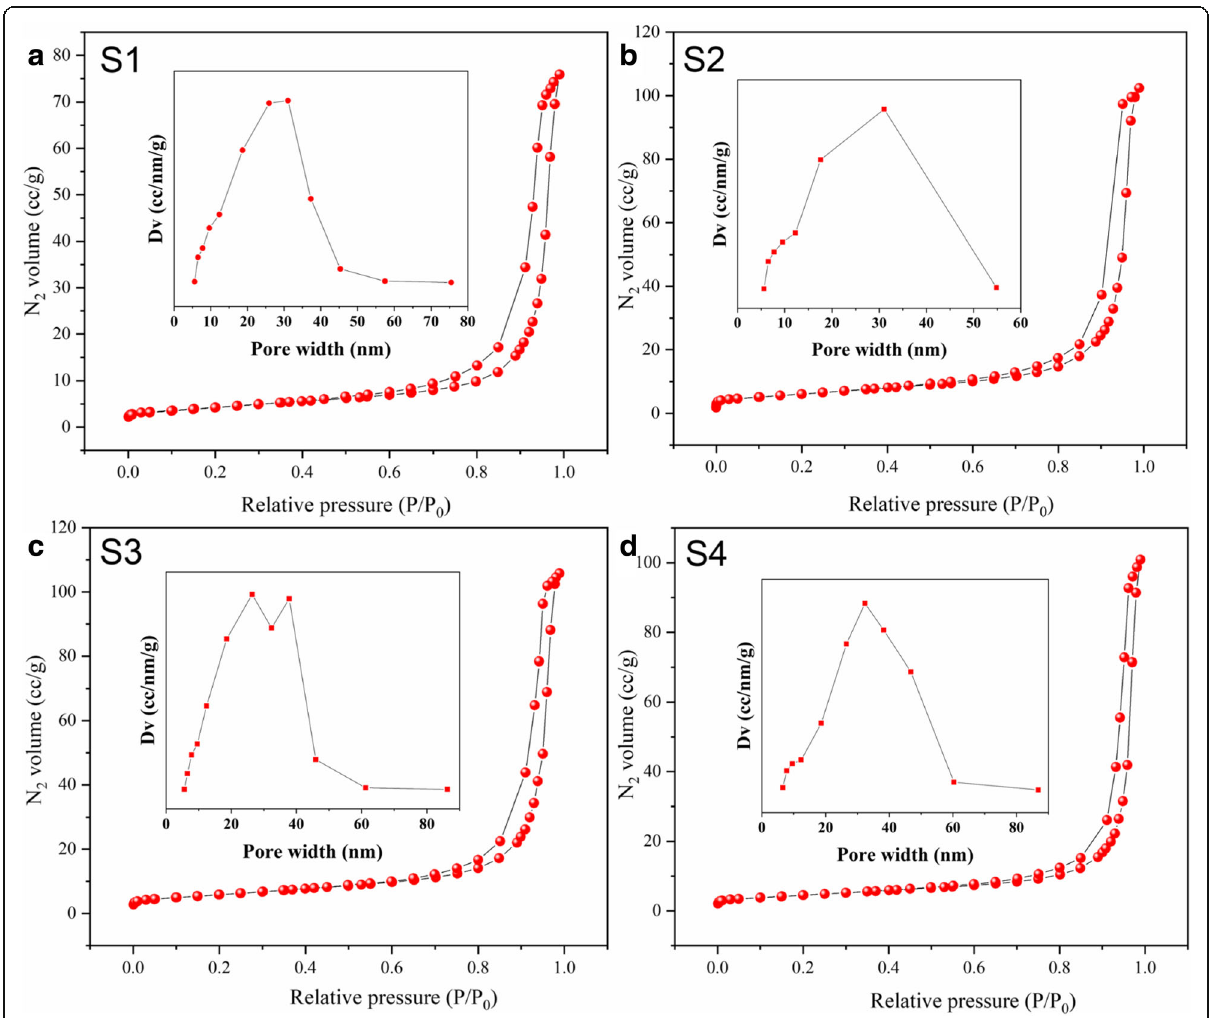
Fig. 4 Nitrogen adsorption-desorption isotherms and corresponding pore size distribution curves of S1 ( a ), S2 ( b ), S3 ( c ), and S4 ( d )